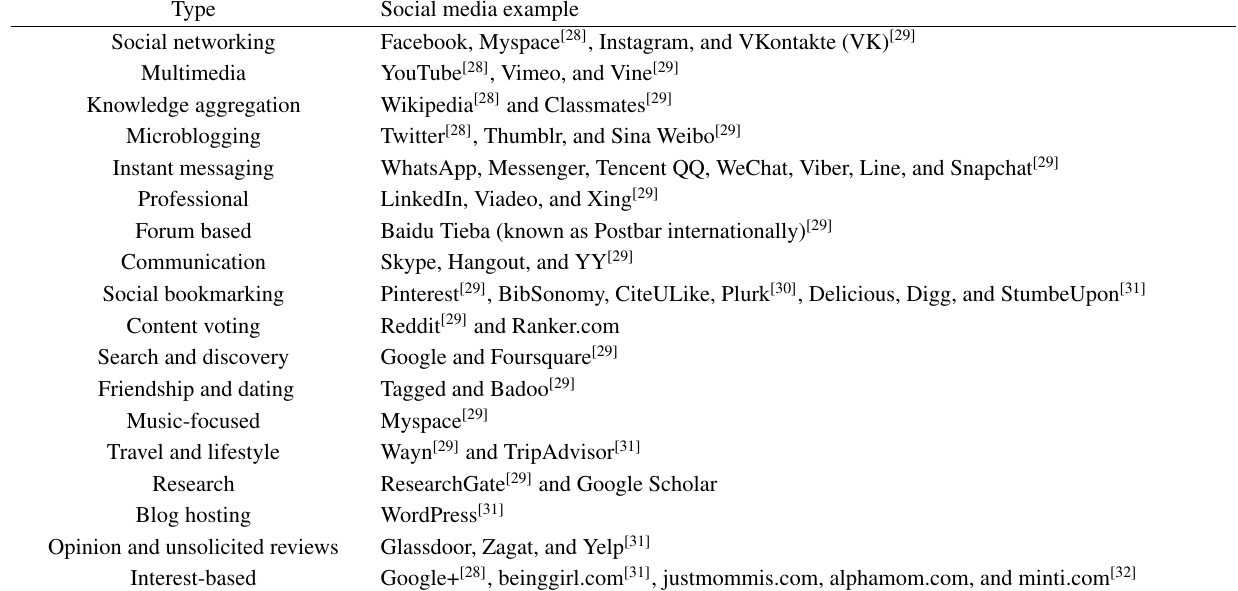
Table 2 Social media types